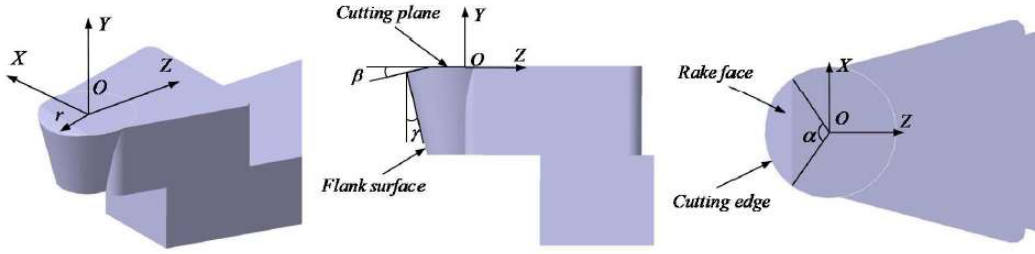
Figure 10. Illustration of tool geometry.